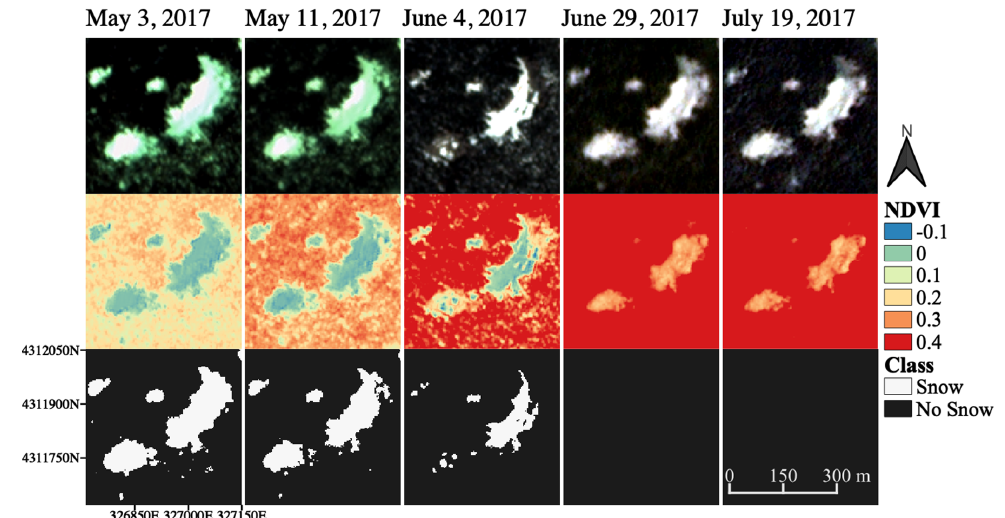
Figure 3. A time series of snowmelt on a rocky outcropping, with true color images ( top ), normalized difference vegetation index (NDVI) (middle) and snow classification results ( bottom ). Snow is not easily distinguishable from rock in true color images ( top ). Since snow is associated with low NDVI values, observations of an increase and subsequent stabilization of NDVI values ( middle ) throughout the growing season were used to identify the transition from snow to rock ( bottom ) when selecting training sites.